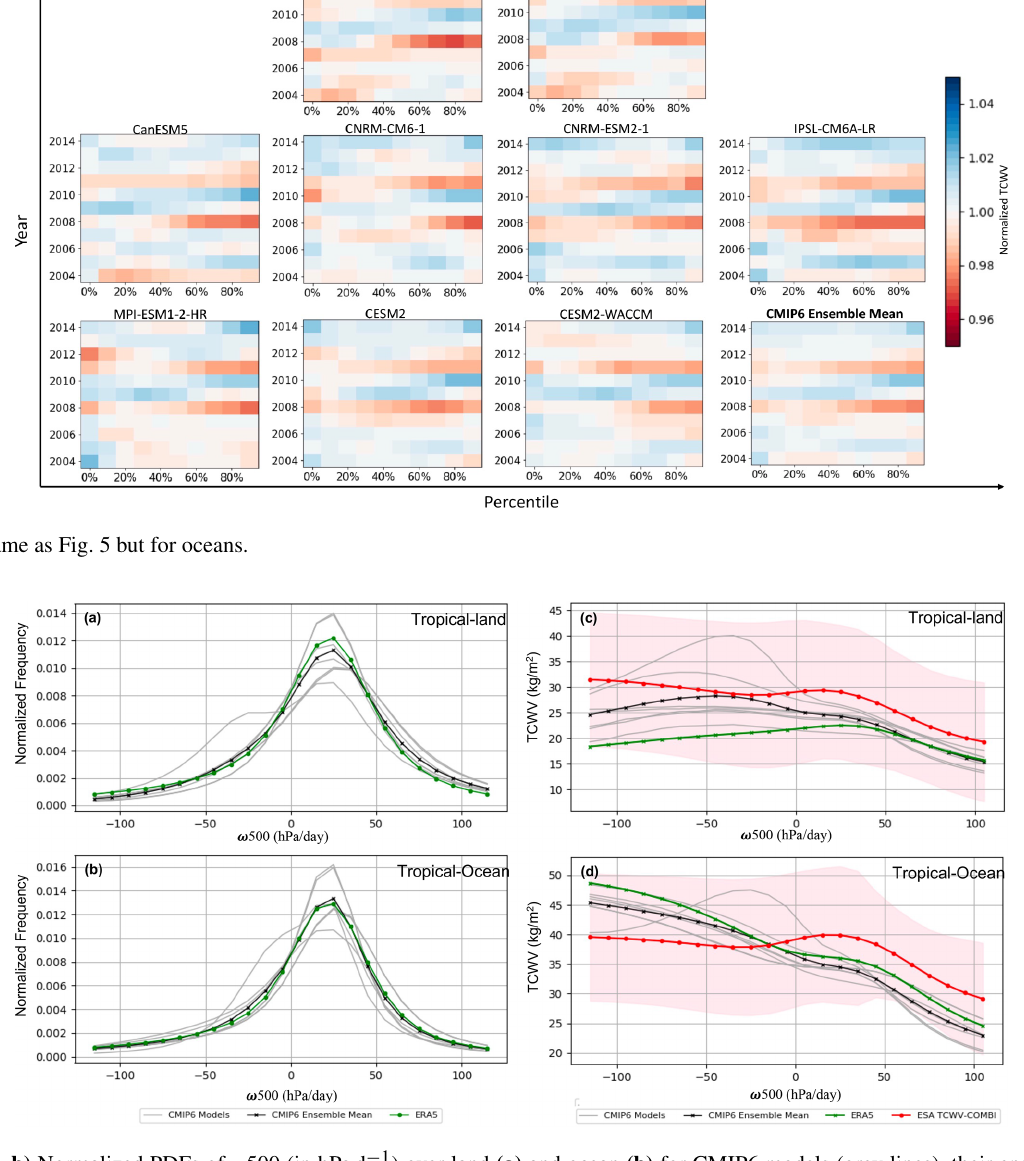
Figure 7. (a, b) Normalized PDFs of ω 500 (in hPad − 1 ) over land (a) and ocean (b) for CMIP6 models (grey lines), their ensemble mean (black line) and ERA5 (green line). (c, d) Mean TCWV from the CMIP6 models (grey lines), their ensemble mean (black line), ERA5 (green line) and ESA TCWV-COMBI (red line) in different circulation regimes of ω 500 over land (c) and ocean (d) areas. The shaded area in pink represents the σ of each bin in TCWV-COMBI